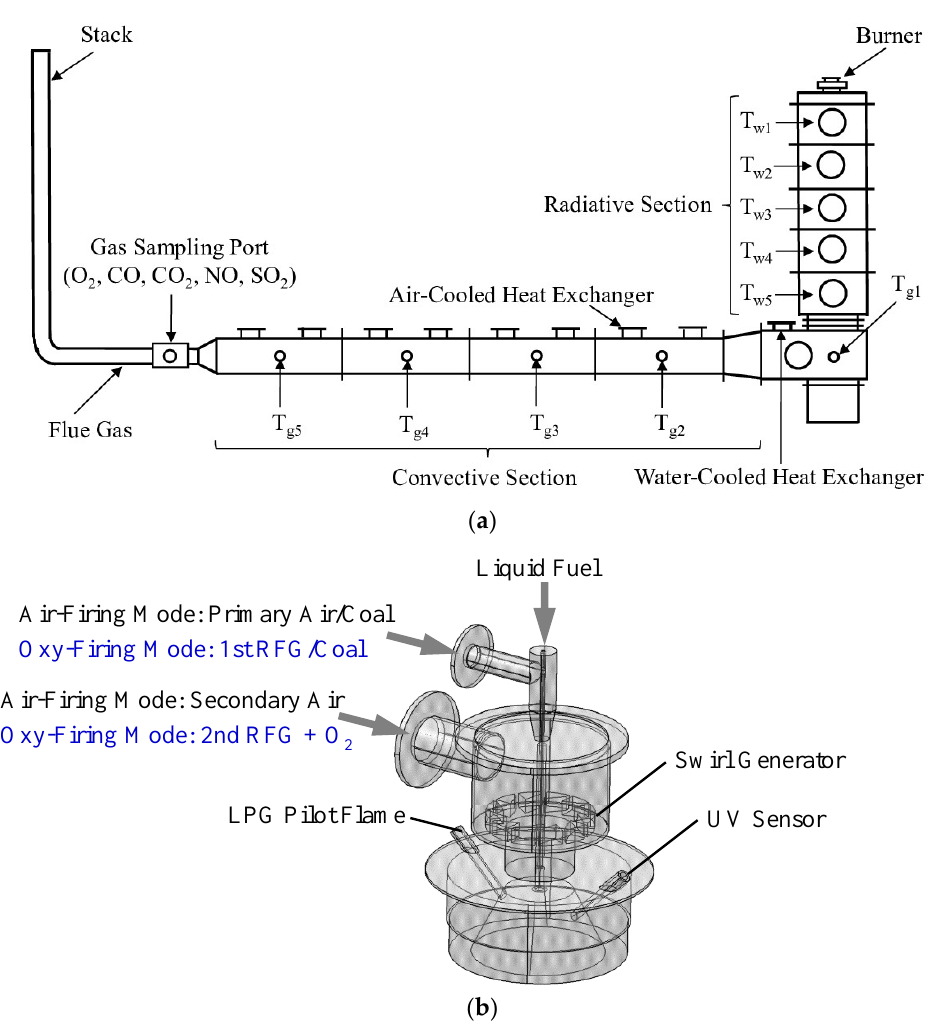
Figure 2. ( a ) Locations of the thermocouple measurement and gas sampling in the combustion test furnace. ( b ) The multi-fuel burner.